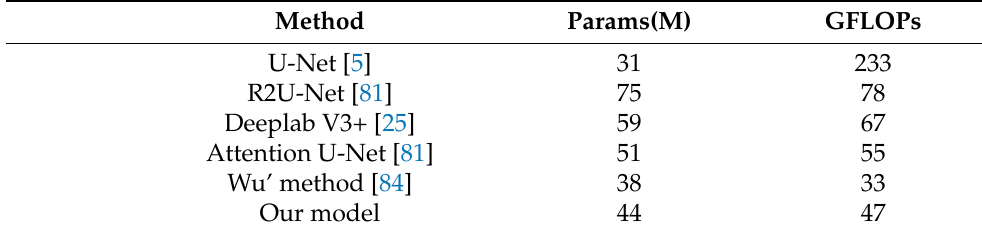
Table 4. The computational complexity of related segmentation